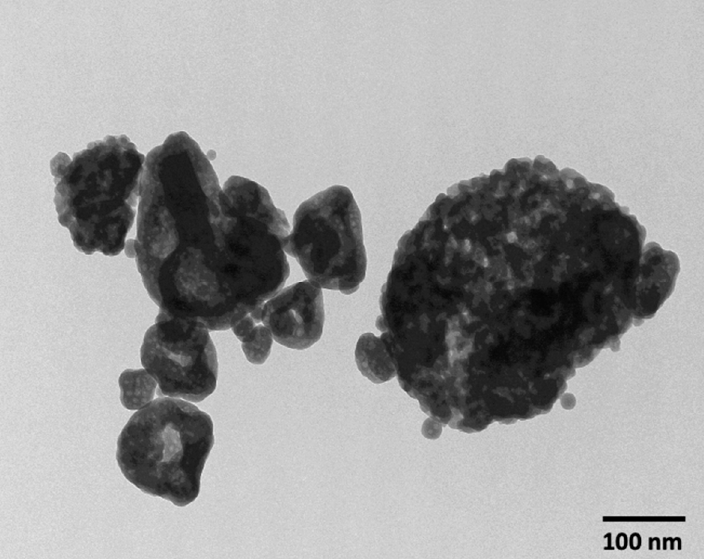
Figure 1. TEM of nano-sized amorphous calcium phosphate (NACP) synthesized via spray-drying technique and collected using an electrostatic precipitator.